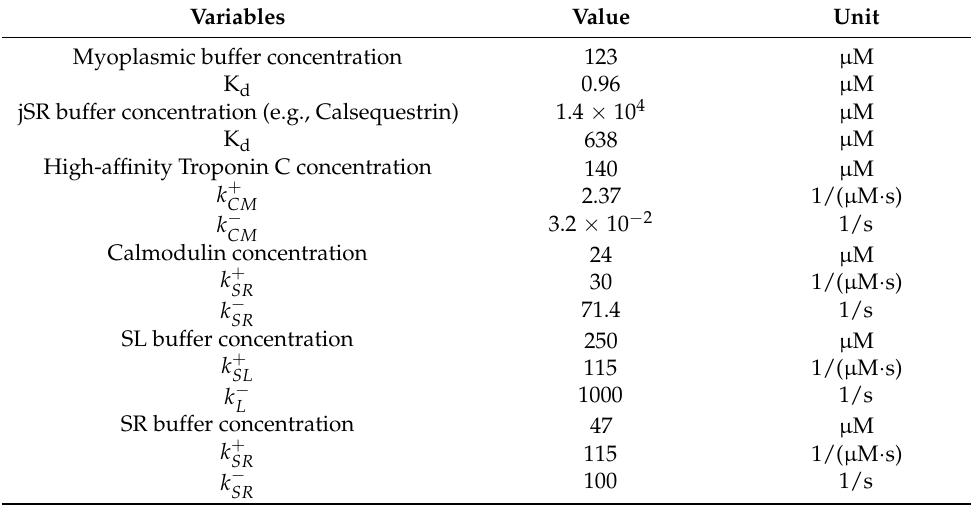
Table A3. Calcium buffers.